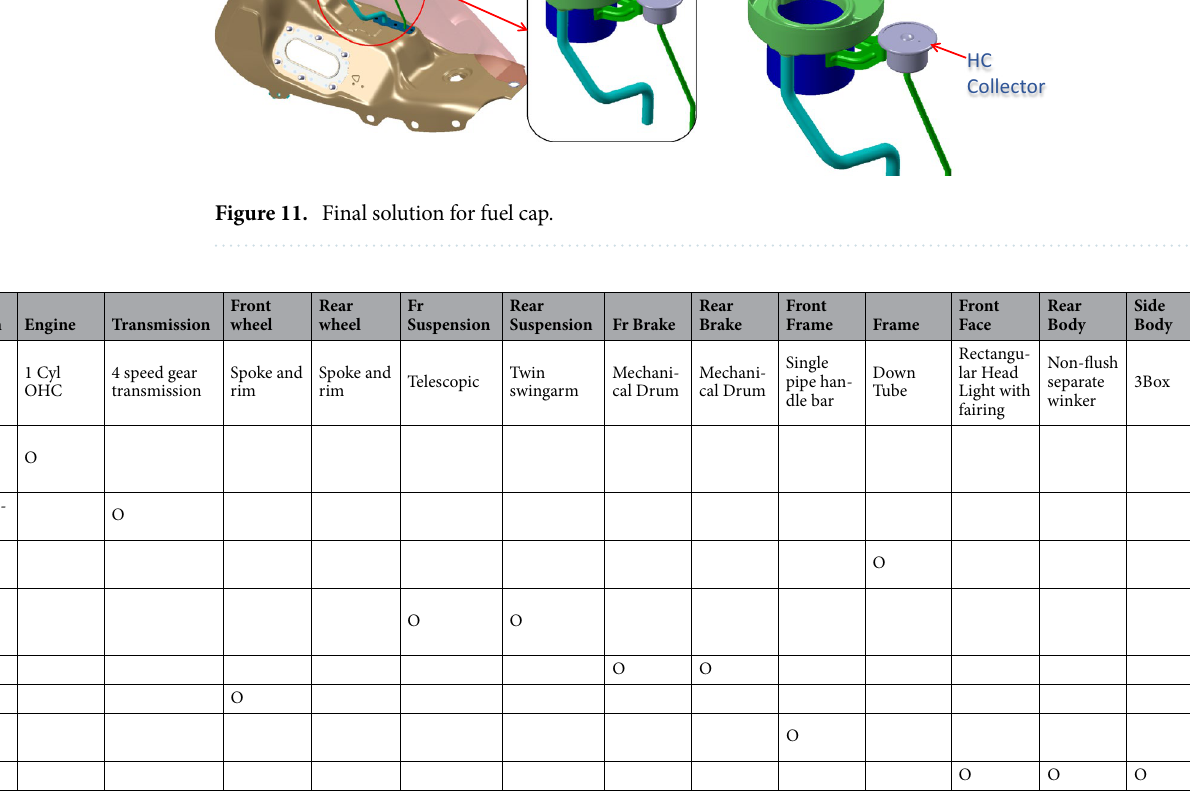
Table 15. Function-system allocation for base